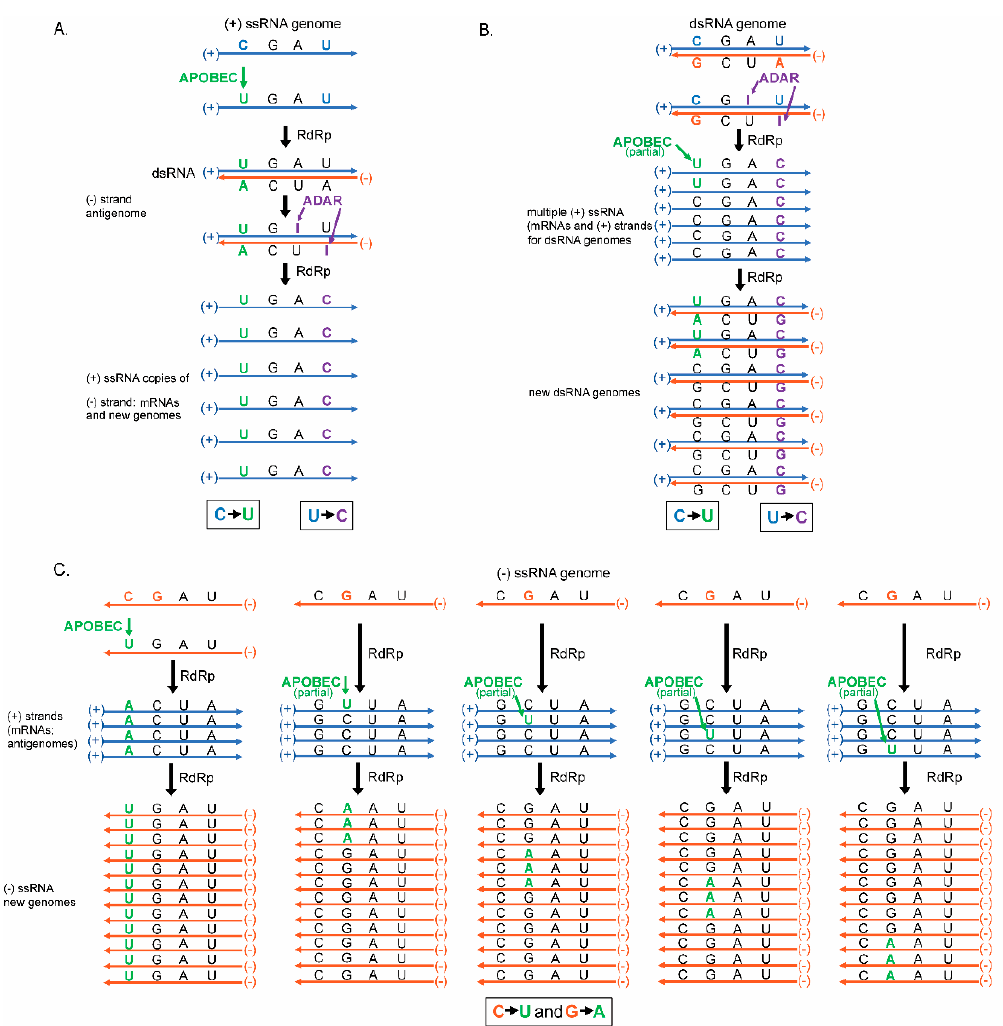
Figure 1. RNA virus genome type and mode of replication define mutation strand bias in the progeny. Presented are the modes of RNA viral genome replication and how mutagenesis with the ssRNA-specific cytidine deaminase APOBEC and the dsRNA-specific adenosine deaminase ADAR affect the genomes of the cell. Positive (+) strands are shown in blue. Negative ( − ) strands are shown in orange. Color codes, same as a strand color, are assigned to nucleotides that will be mutated in the next steps. APOBEC mutagenesis and resulting mutant nucleotides are shown in green. ADAR mutagenesis in dsRNA and resulting mutant nucleotides are shown in purple. Nucleotides that stayed not mutated in the progeny are shown in black. Predominant classes of mutations in progeny ssRNA genomes or in coding (+) strand RNA of dsRNA genomes is shown in boxes. ( A ) Viruses with positive (+) ssRNA genome. The infecting (+) strand RNA genome is used as a template by RNA dependent RNA polymerase (RdRp) to synthesize a dsRNA with both (+) and ( − ) strands. A single dsRNA molecule is subsequently used to generate multiple copies of (+) strand RNA transcripts and/or genomes. A single APOBEC-induced C to U change in the infecting genomic (+) strand ssRNA would amplify in all viral progeny (C to U mutations). An ADAR-induced A to I (inosine) change in the (+) strand dsRNA would not reproduce in genomes of viral progeny. In contrast, an ADAR-induced A to I change in the (-) strand dsRNA would be copied into multiple (+) strand RNA transcripts and thus be amplified in the viral progeny as U to C mutations in genomic (+) strand ssRNA. ( B ) Viruses with double-stranded (ds) RNA genomes. Multiple (+) ssRNA transcripts and/or genome precursors are generated by RdRp. Each (+) ssRNAs precursor is then used to generate a dsRNA genome. Only ADAR-induced A to I mutations in ( − ) strand are amplified into multiple dsRNA genomes via copies of (+) strands. Since there are multiple (+) strand interme- diates, there is a chance of detectable level of C to U APOBEC-induced deamination in a fraction of (+) strands. ( C ) Viruses with negative ( − ) ssRNA genomes. Several (+) ssRNA transcripts and/or precursors of ( − ) ssRNA genomes are generated by RdRp that are then used to generate multiple ( − ) ssRNA genomes. ( − ) ssRNA genomes of infecting particles as well (+) ssRNA precursors can serve as a substrate for APOBEC mutagenesis. The change (C to U or G to A) recovered by sequenc- ing progeny genomes would be defined by the strand which is deaminated by APOBEC. Multiple C to U mutant molecules will arise from a single deamination in the infecting ( − ) ssRNA genome. Smaller number of G to A changes would result